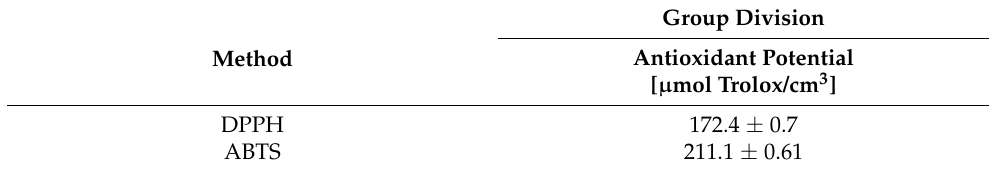
Table 1. The antioxidant potential of lyophilized chokeberry extract used in the current